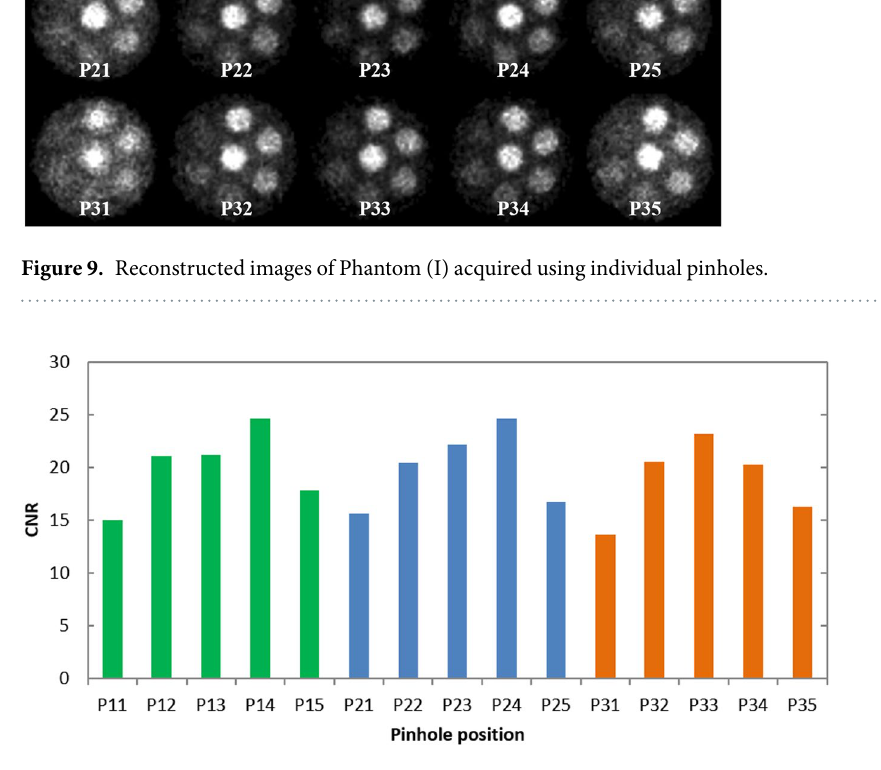
Figure 10. CNRs of reconstructed images of Phantom